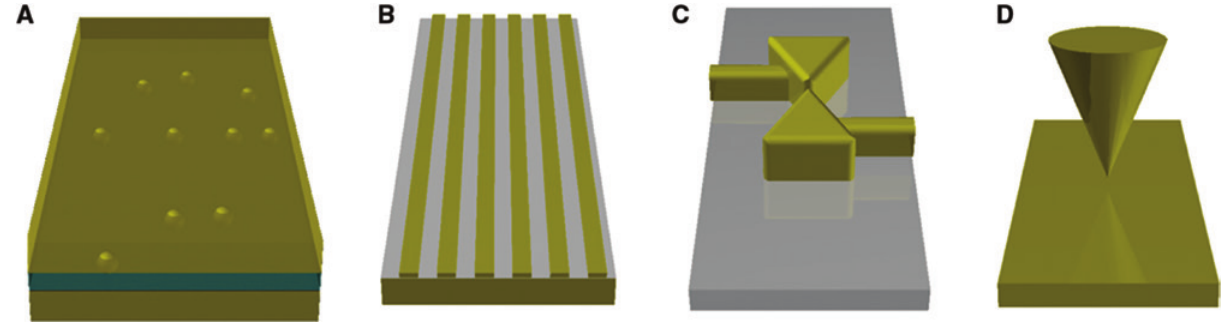
Figure 1: Sketch of various MIM structures, where a LSPR mode can be excited by IET. (A, B) Au substrate coated with a thin insulating layer ( ~ 1 nm) with the antenna structure on top. (A) Spin-coated nanoparticles partially embedded in a polymer and top gated by an additional conducting layer, e.g. an evaporated gold film. (B) Lithographically etched wires. (C) Planar antenna structure on insulating substrate with sufficiently small gap. (D) Noble metal STM tip above a noble metal